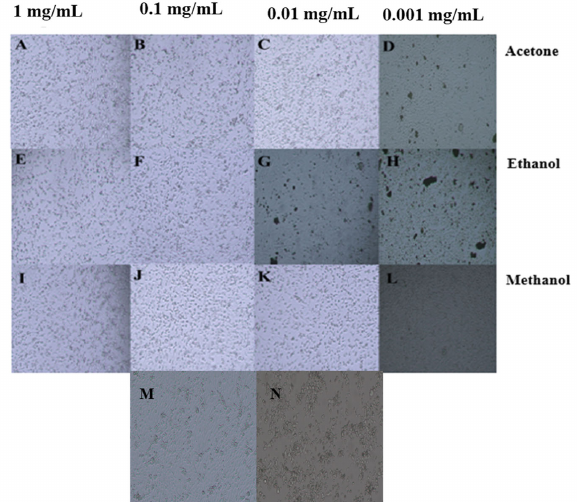
Figure 4. Antiproliferative activity of Coronopus didymus against HepG2 cells. ( A – D ) represent treat ‐ ment with acetone ‐ based extracts at a concentration of 1 mg/mL, 0.1 mg/mL, 0.01 mg/mL and 0.001 mg/mL, respectively. ( E – H ) depict treatment with ethanol ‐ based extracts at a concentration of 1 mg/mL, 0.1 mg/mL, 0.01 mg/mL and 0.001 mg/mL, respectively. ( I – L ) are treatment with methanol ‐ based extracts at a concentration of 1 mg/mL, 0.1 mg/mL, 0.01 mg/mL and 0.001 mg/mL, respec ‐ tively. ( M , N ) represent negative and positive control,